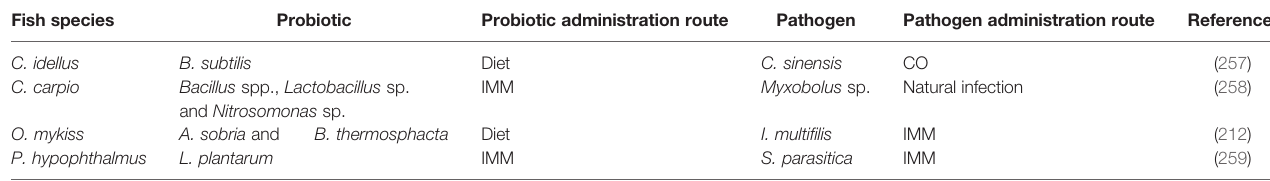
TABLE 3 | Probiotics assayed in vivo in aquacultured species which have shown to confer signi fi cant resistance against parasites. Fish